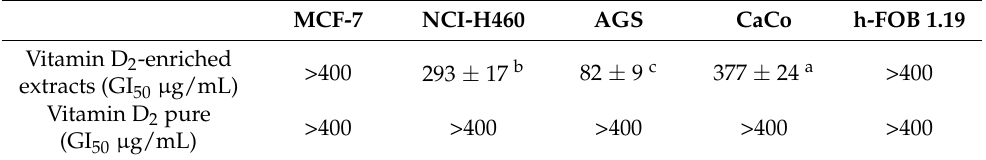
Table 3. Antiproliferative and cytotoxicity activities of vitamin D 2 -enriched extracts using